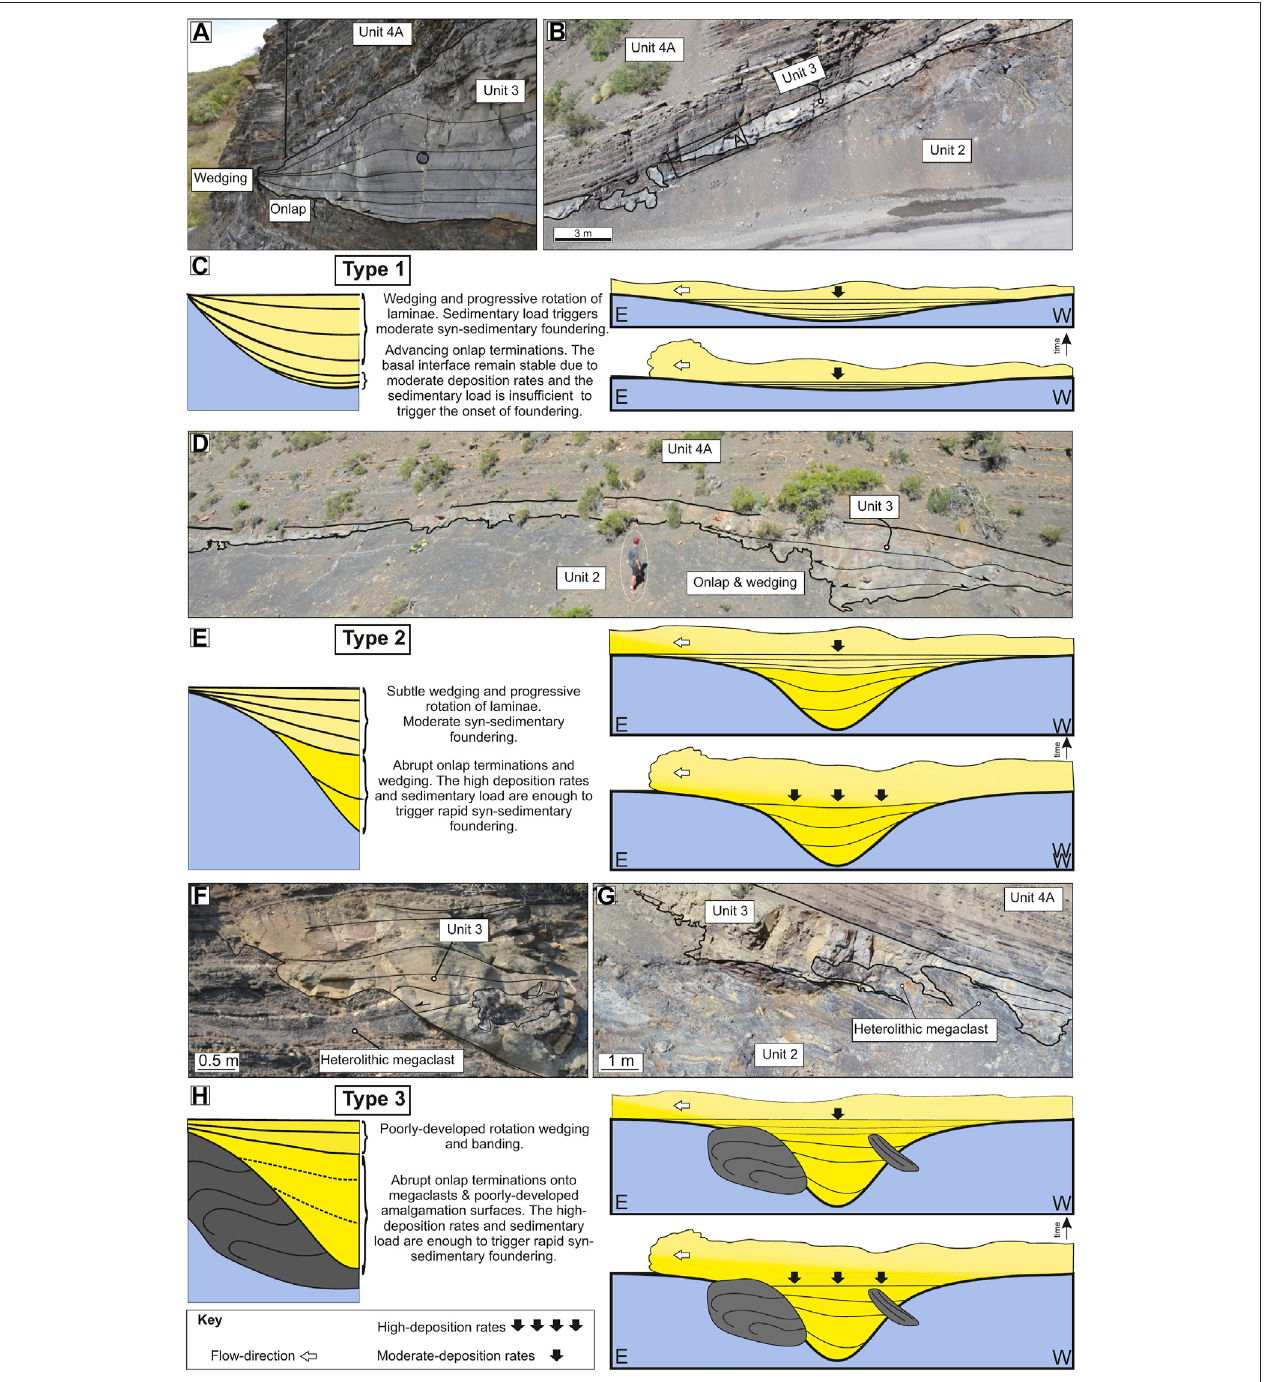
FIGURE9| Illustrativediagramoffounderedsandstonearchitectureandamodelfortheirdevelopment.Type1: (A) Thin-beddedsandstonewithonlaptermination at the base, indicating interaction with inherited relief and wedging associated with the syn-depositional foundering. (B) Bodies wedge smoothly, forming lenticular bodieswith fl attops.NotethelocationofA)indicatedbyablackrectangle. (C) Sketchofthearchitecture andevolutionarymodelofType1architecture:Initialdeposition is insuf fi cient to trigger the foundering. Type 2: (D) Thick-bedded foundered sandstones with associated thinner margins. Central parts are composed of sandstonesdepositedbyhigh-densityturbiditycurrents,whereasthethinnermarginsaresandstonesinterpretedasbeingdepositedundermore fl uidalsedimentgravity fl ows(Transitional fl ows). (E) SketchofthearchitectureandevolutionarymodelofType2architecture:Initialdepositionisenoughtotriggerthefoundering.Type3: (F,G) The shape of the thick-bedded sandstone bodies depends on the size and geometry of the thin-bedded megaclast. See Panel 5 for more detail. (H) Sketch of the architectureandevolutionarymodelofType2architecture:Whilefoundering,thesandstonemightbeprotrudedbythemegaclastduetoitshighercompetencethanthe surrounding debrite